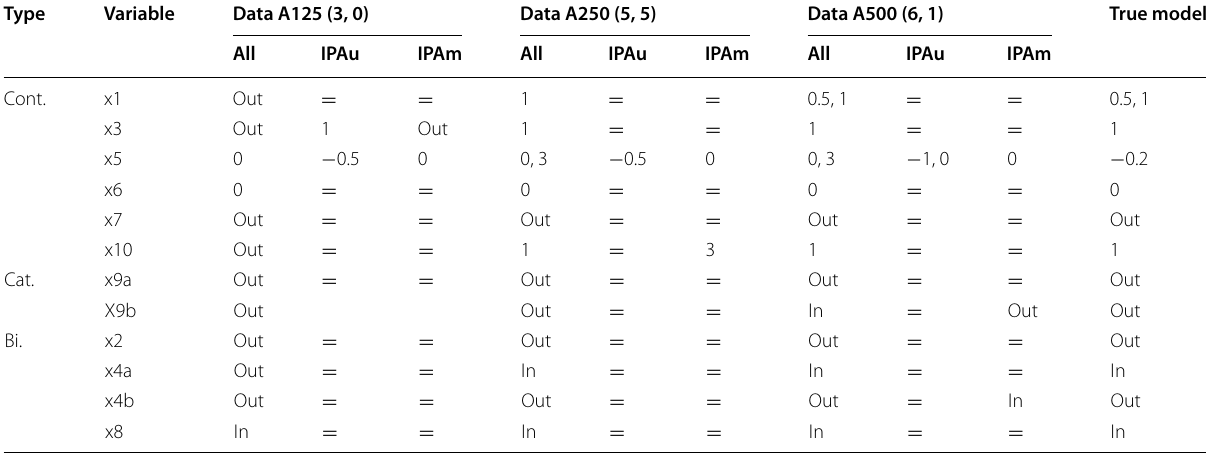
Table 4 Data A125, A250, and A500. Selected functions from MFP models with all data (“all”) and after removal of IPs identified from the univariable (“IPAu”) and multivariable (“IPAm”) diagnostic analyses. The number of IPs identified in each respective analysis is shown in parentheses next to the name of the data